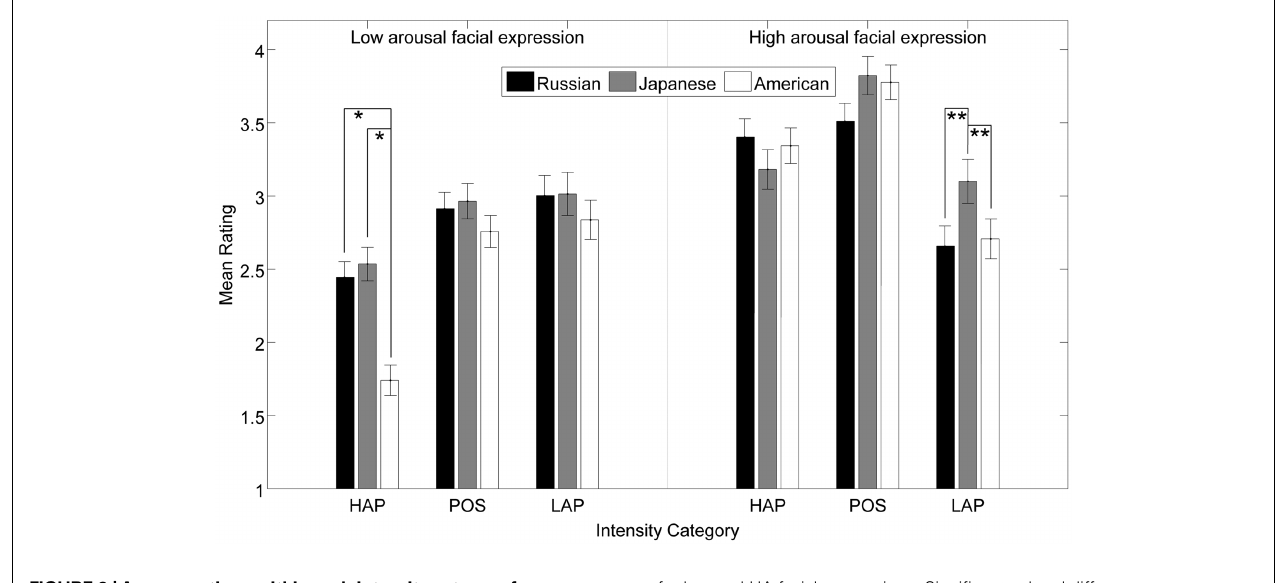
FIGURE 2 |Average ratings within each intensity category for advertisements showing LA and HA facial expressions across cultures. The figure shows mean ratings across cultures (Russian, Japanese, American) and emotion intensity categories (HAP, POS, LAP)